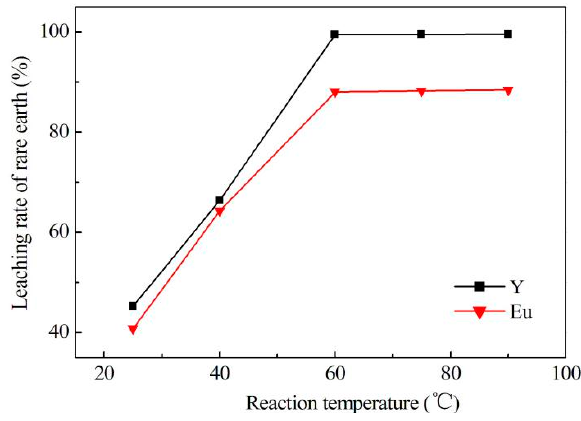
Figure 3. Effect of leaching temperature on the REE leaching test (4 mol/L HCl concentration, 0.2 mL/g hydrogen peroxide, 4 h leaching time).